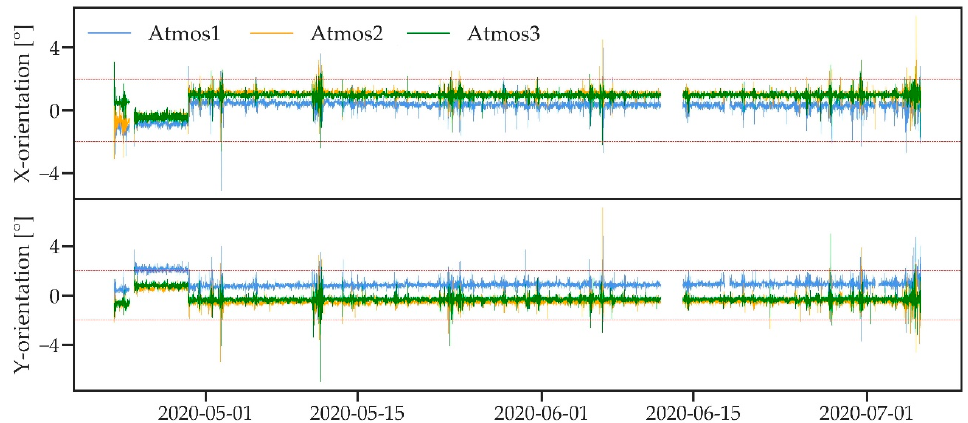
Figure 2. X - and Y -orientation for the three ATMOS41 weather stations. The red dotted line indicates ± 2 degrees from dead level.